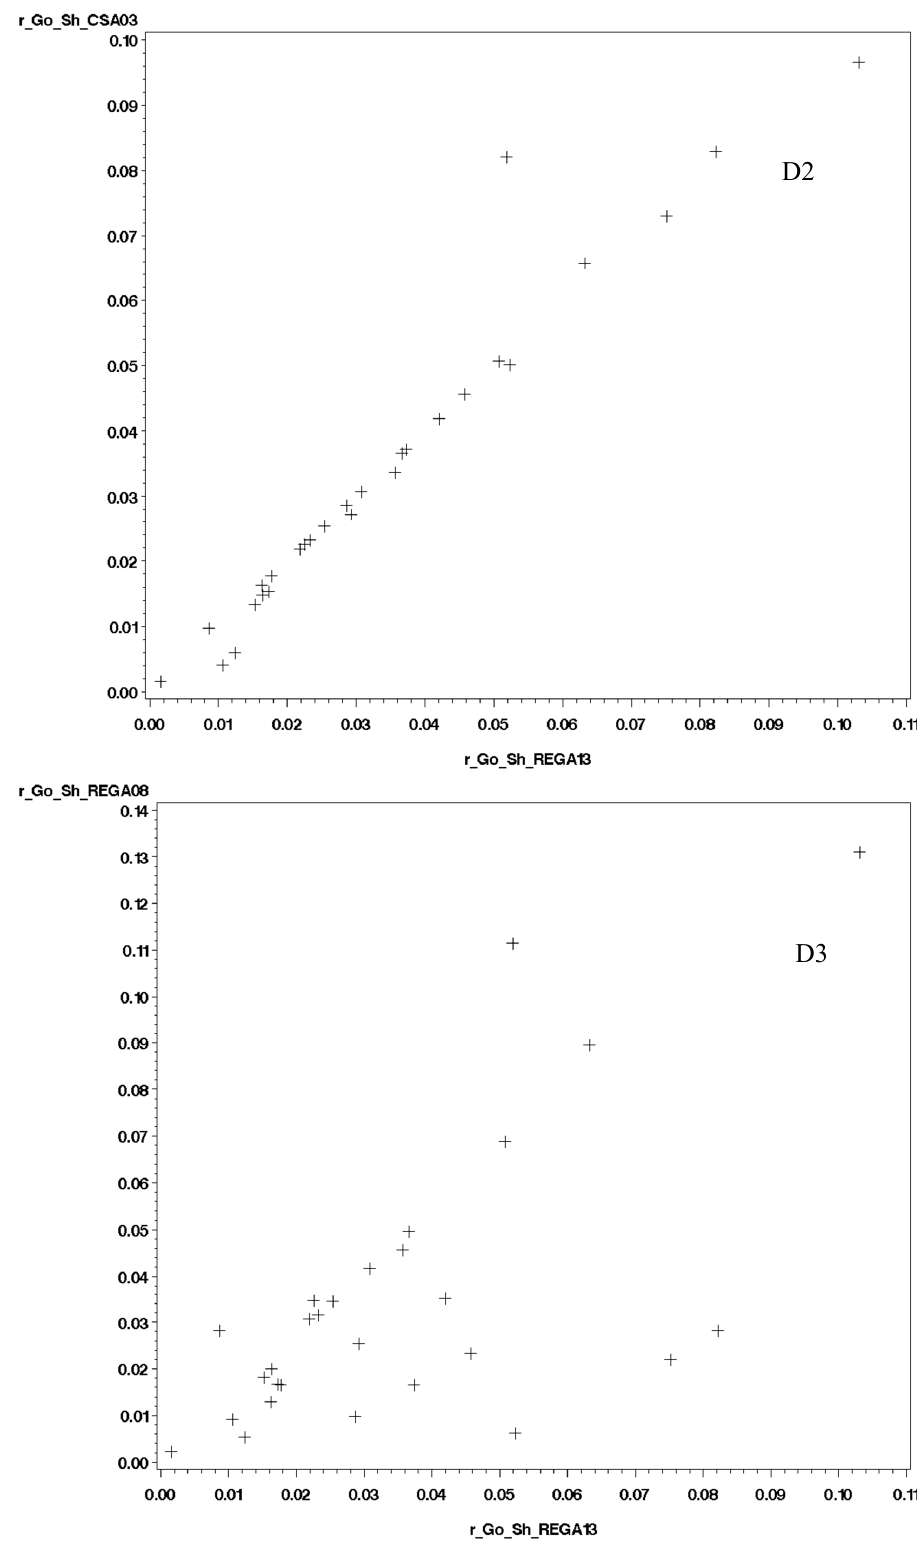
Figure A4. Scatter plots of relative number of heads for goats and sheep (D1–D3).